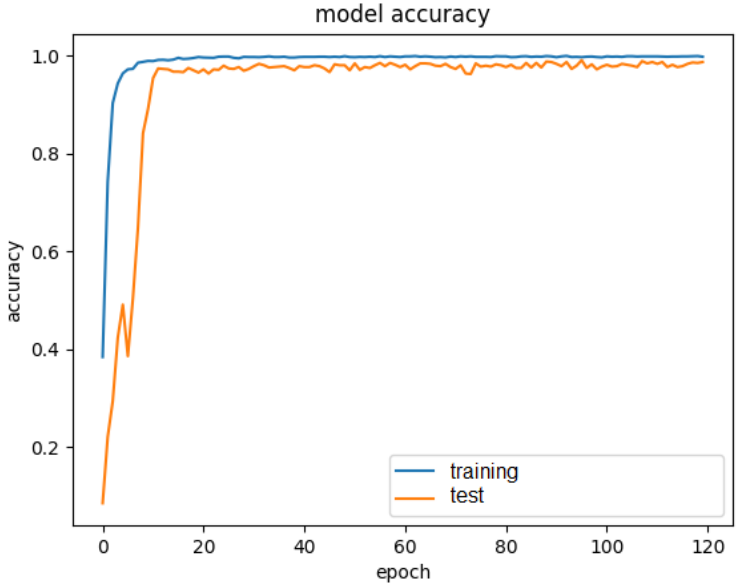
Figure 6. Training and test accuracies with respect to epochs.